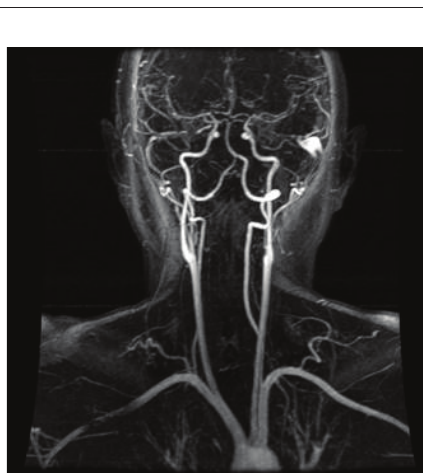
Figure 1: Sagittal view of arterial system (dynamic magnetic reso- nance image).